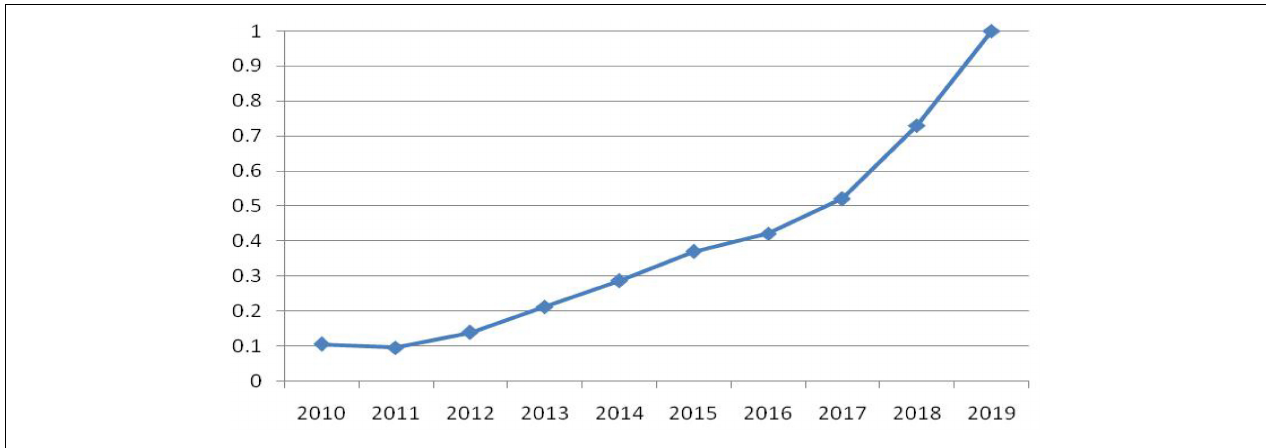
FIGURE 1 | Digital trade development level in China from 2010 to